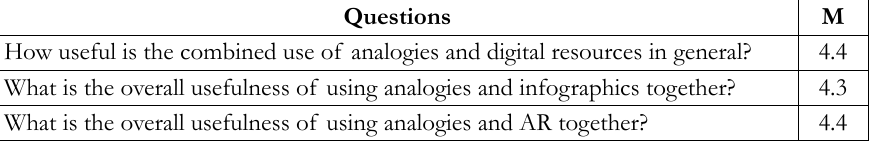
Table 10. Usefulness of the combined use of analogies and digital